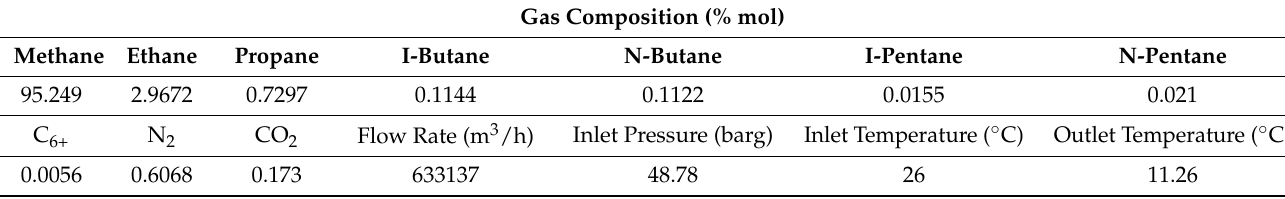
Table 2. Pendik RM-A station gas chromatograph values.